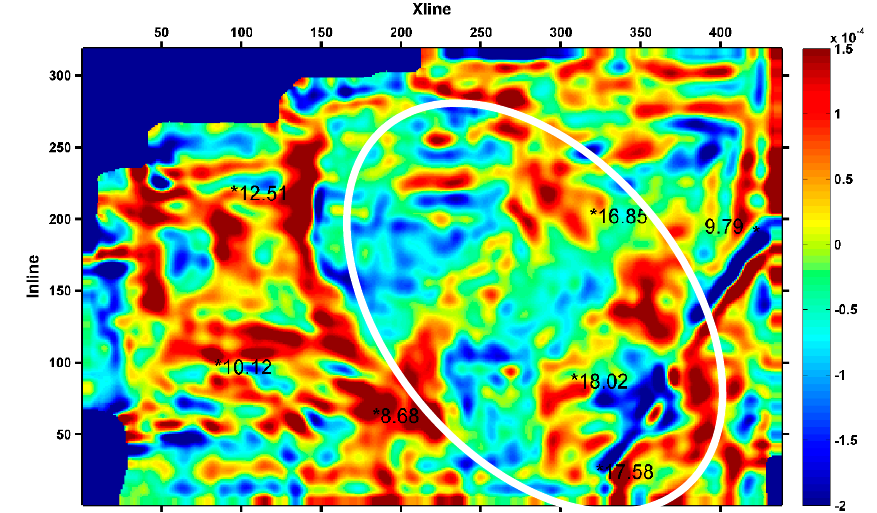
Figure 16. Mean curvature of 3# coal seam.